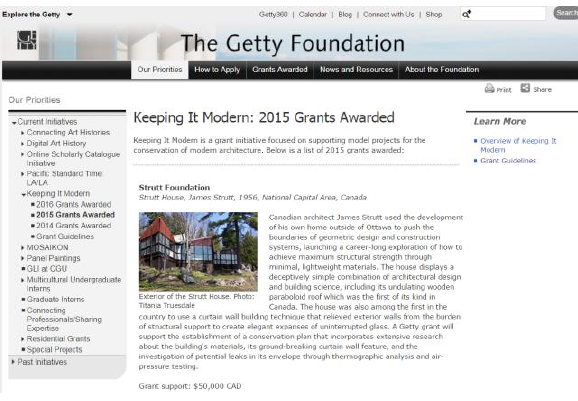
Figure 2. Screen capture ©Getty Foundation web page